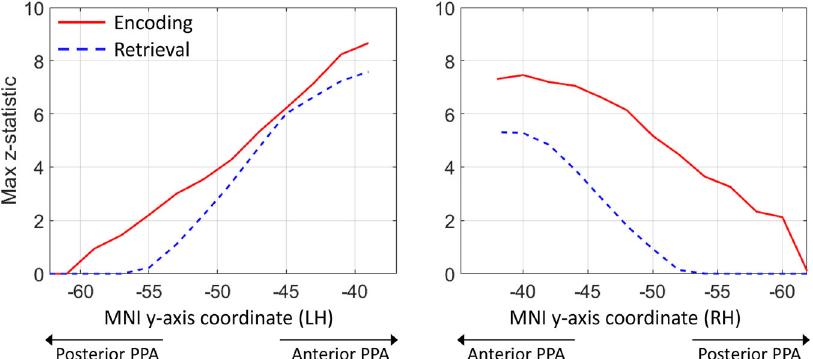
Fig. 4 Encoding and retrieval in the PPA. These plots are based on meta-analytic maps, obtained from NeuroSynth, of locations associated with the terms ‘ encoding ’ and ‘ retrieval ’ . The maximum z-statistic is plotted along the posterior-anterior axis of the parahippocampal place area (PPA).